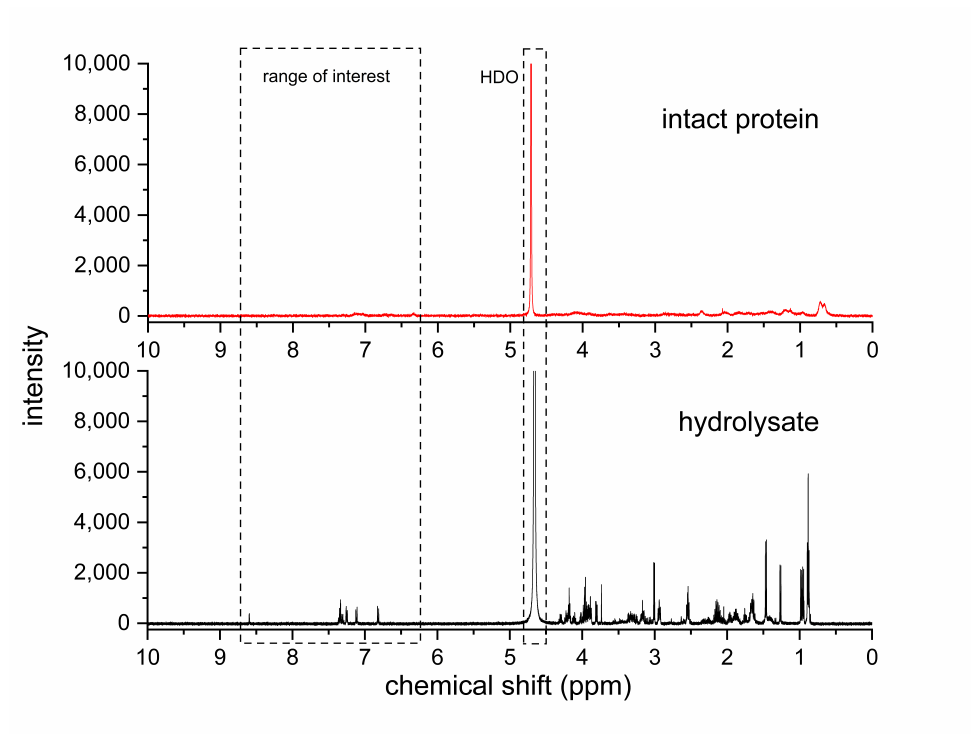
Figure 1. 1 H-NMR spectra of intact (red trace, top) and hydrolyzed protein (black trace, bottom). Approximately 1 mg/mL of protein (BSA) or protein hydrolysate in D 2 O, 500 MHz spectrometer frequency, 16 scans, 5 s relaxation delay, 30 ◦ observation pulse, and 0.5 Hz Lorentzian apodization. The large signal at around 4.7 ppm is that of residual water (as protium deuterium oxide,